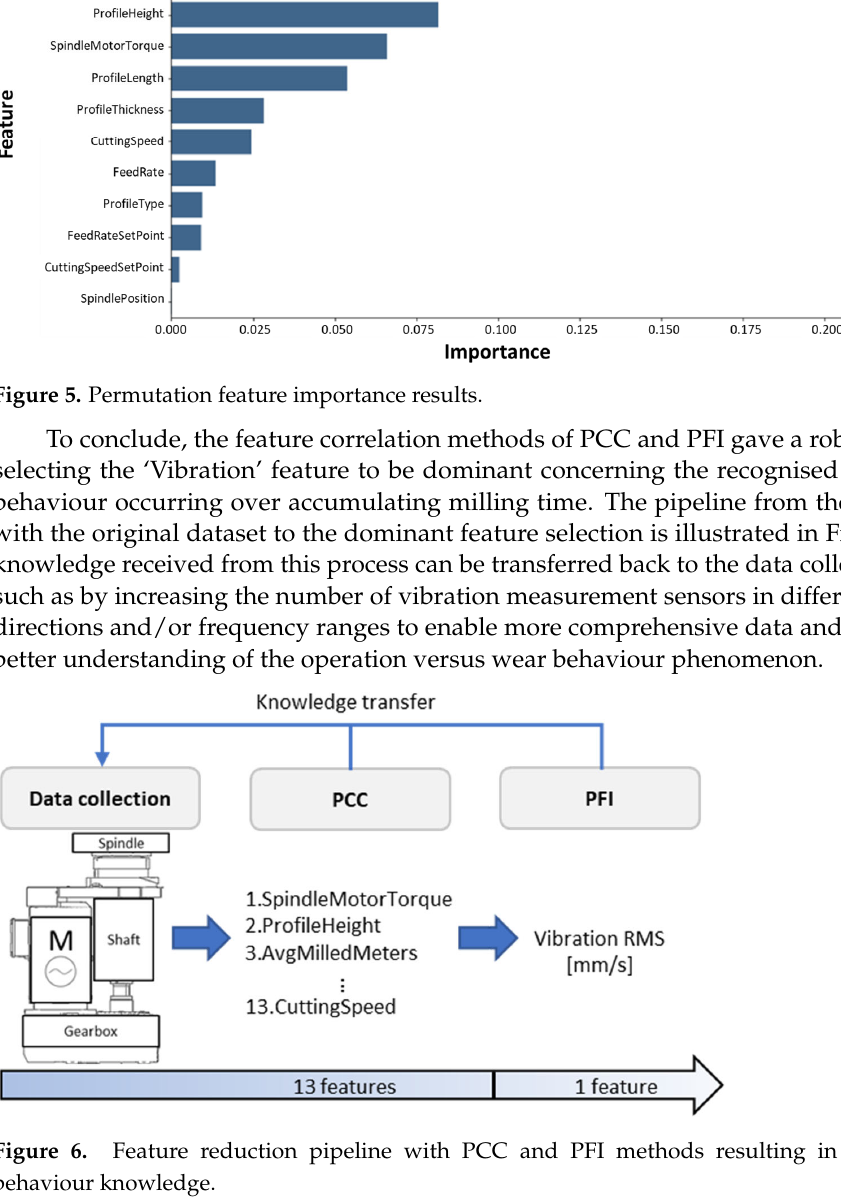
Figure 5. Permutation feature importance results.